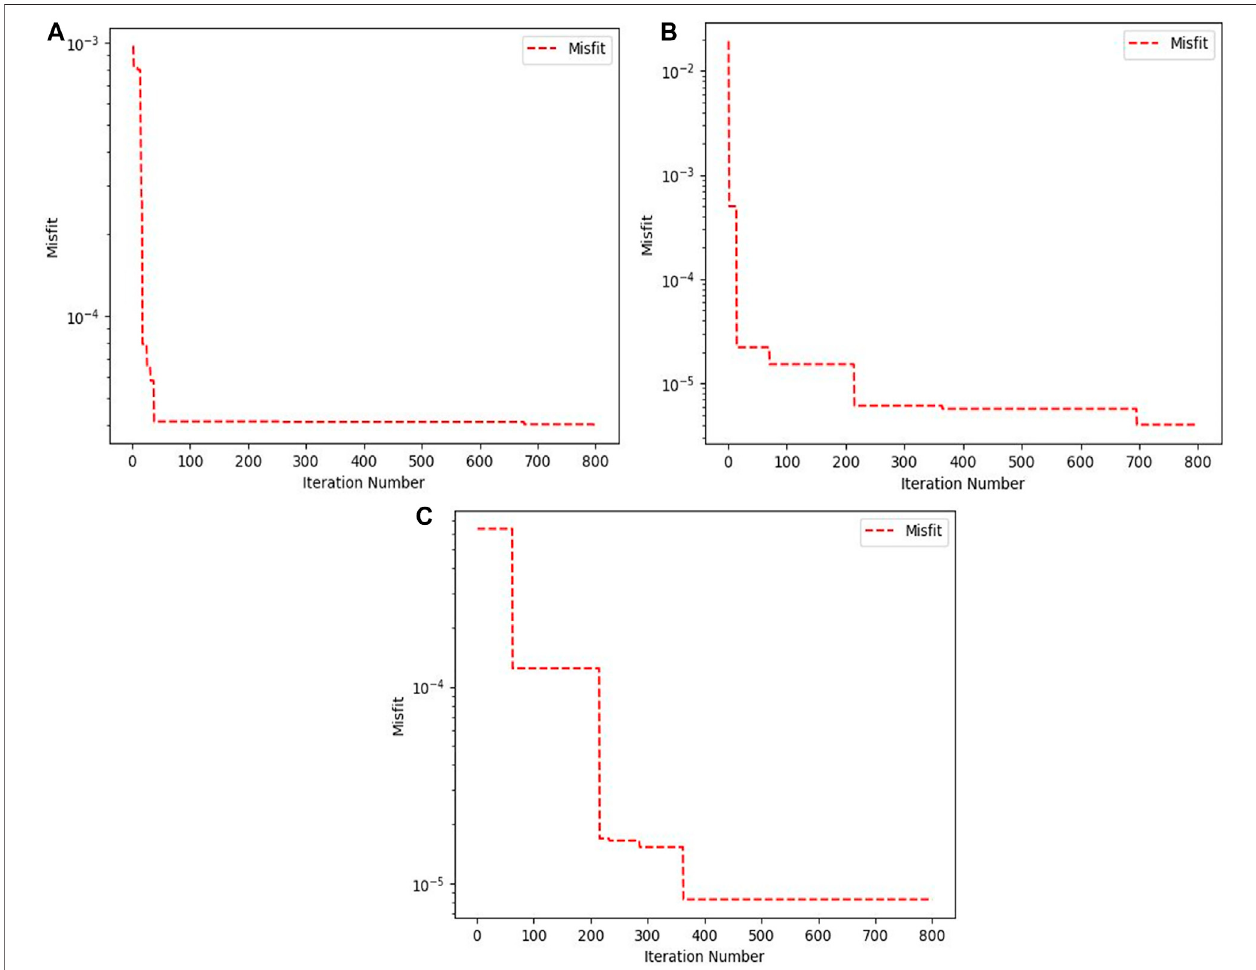
FIGURE 15 | Convergence behavior of the investigated case studies (A) Pima anomaly, (B) Parnaiba anomaly and (C) Hamrawein anomaly.